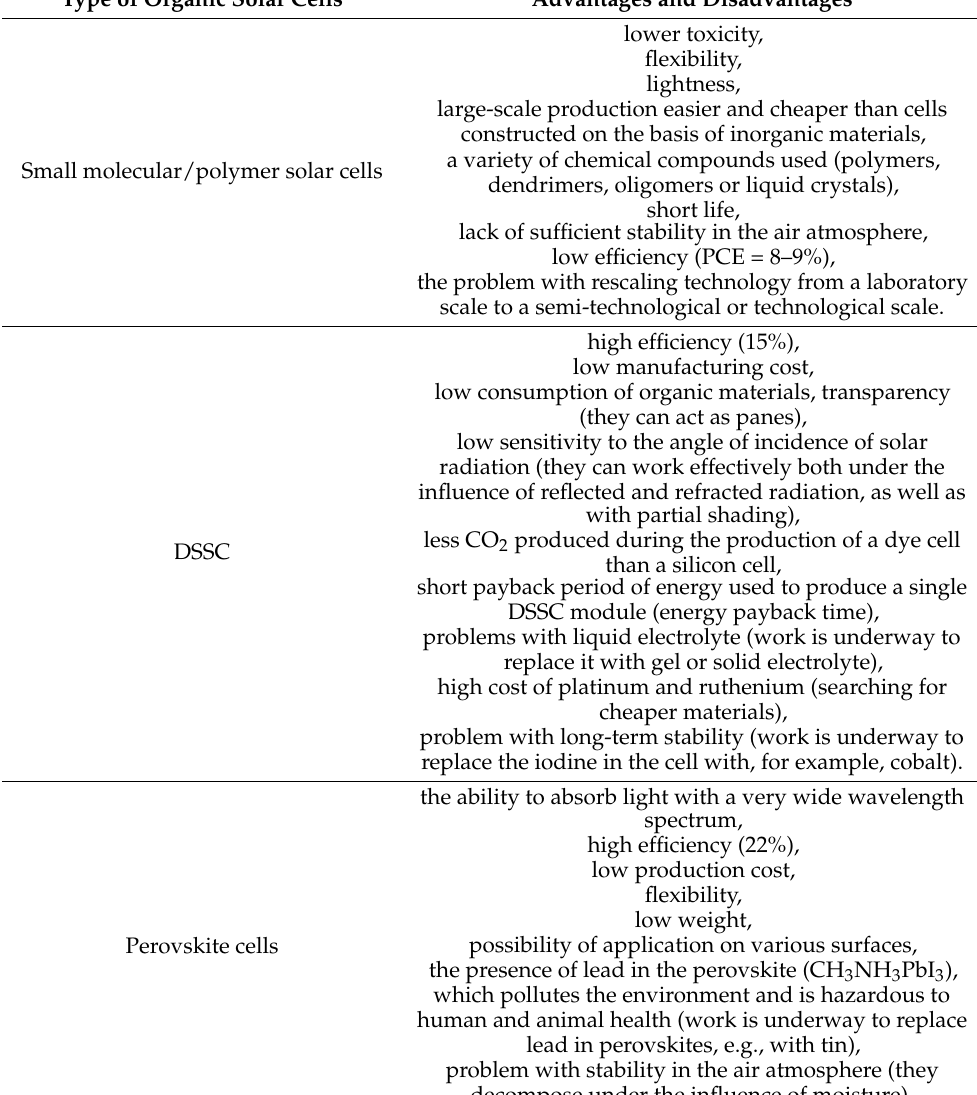
Table 4. The selected advantages and disadvantages of organic/polymer solar